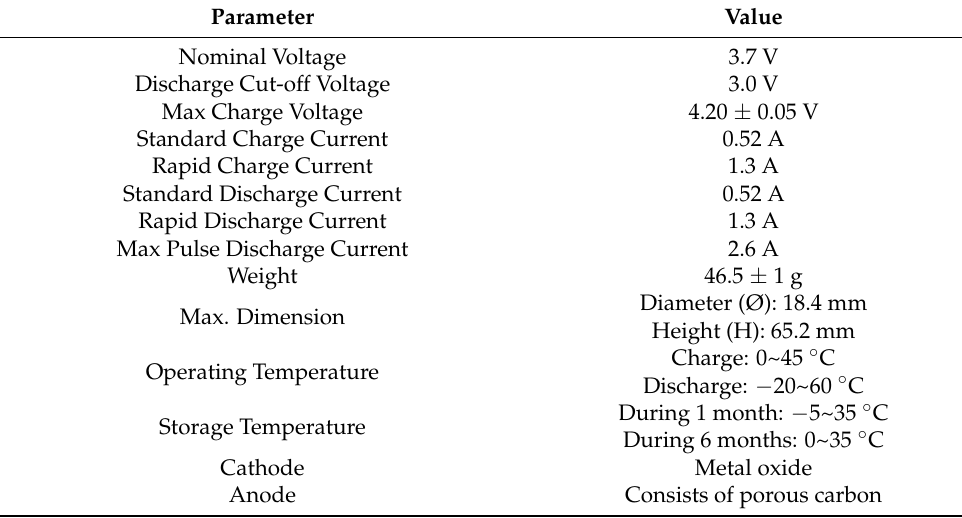
Table A1. Some of the important characteristics of the battery